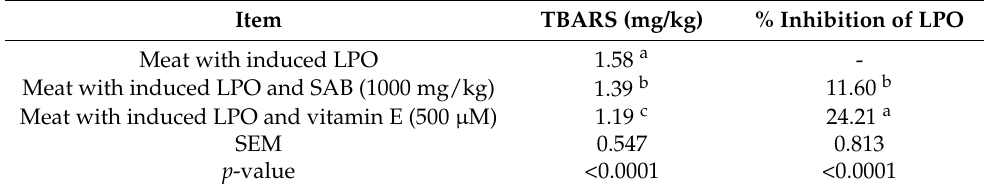
Table 2. Effect of dietary salicin standardized extract from SAB on in vitro-induced lipid peroxidation of meat compared to vitamin E. Item TBARS (mg/kg) % Inhibition of LPO Meat with induced LPO 1.58 a